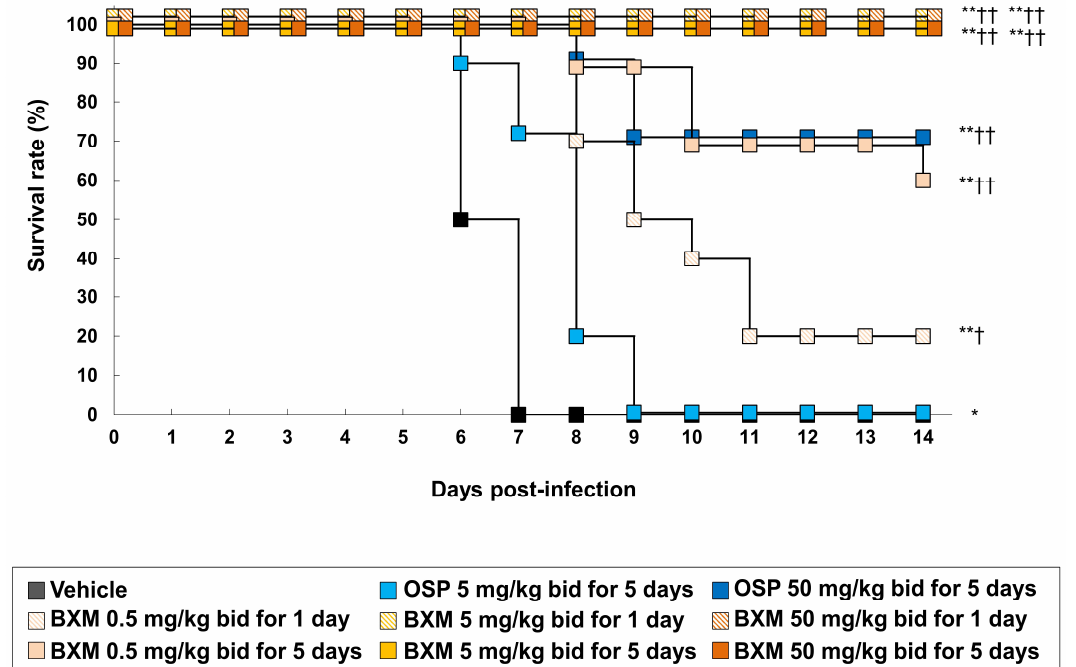
Figure 1. Therapeutic effects of baloxavir marboxil (BXM) on survival in a lethal infection model of mice infected with H5N1 virus. The mice were intranasally inoculated with 75 times of 50% tissue culture infectious dose (TCID 50 )/mouse (31.3 times of 50% mouse lethal dose [MLD 50 ]) of the A/Hong Kong/483/1997 (H5N1) virus, and treatment was started immediately after viral inoculation ( n = 10/group). The survival time was then monitored throughout a 14-day period after the infection. The log-rank test was performed to compare the survival time between each group (* p < 0.01, **, p < 0.001 compared with vehicle, † p < 0.01, †† p < 0.001 compared with oseltamivir phosphate (OSP) at 5 mg/kg twice daily).